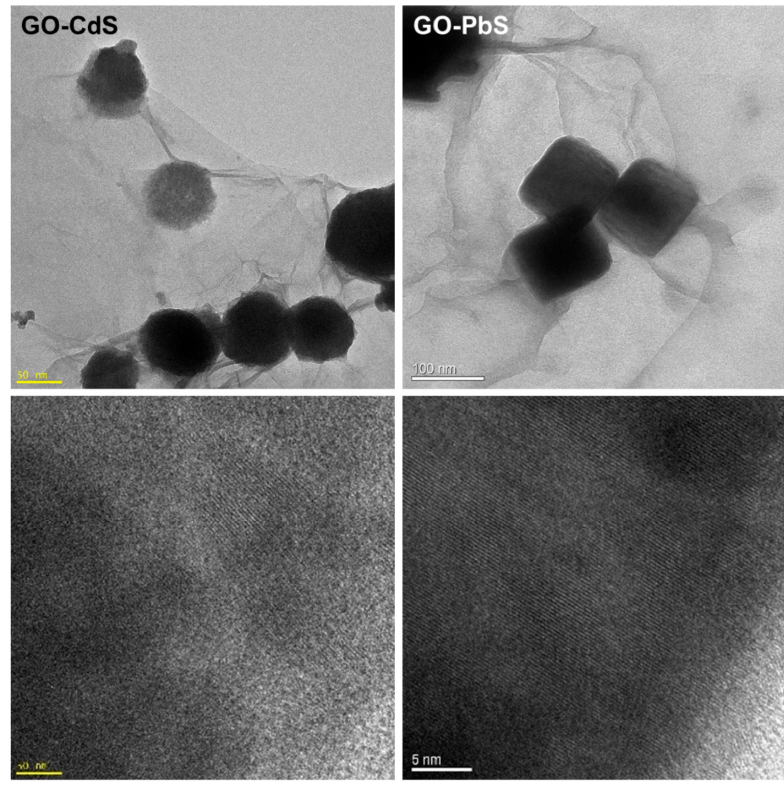
Figure 5. Graphene oxide (GO) sheets decorated with CdS and PbS nanophases: TEM images ( top ) and corresponding HRTEM images ( bottom ).